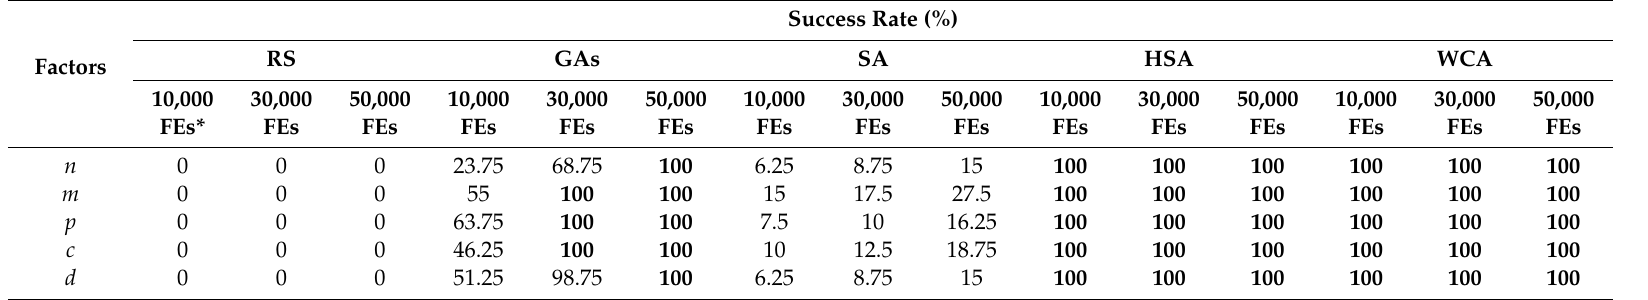
Table 5. Performance comparison of modified Hanoi network design problems (success